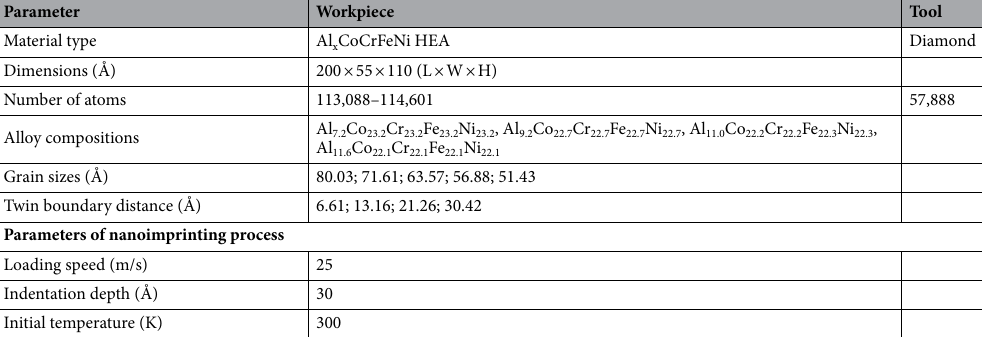
Table 1. The parameters of sample and MD simulation of nanoimprinting.